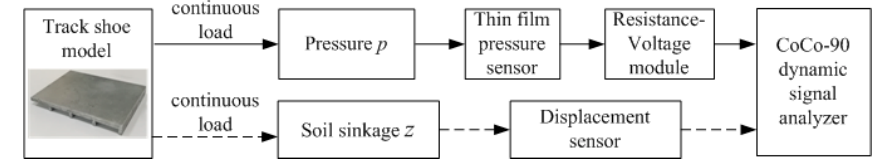
Figure 10. Curve of pressure and system output voltage.